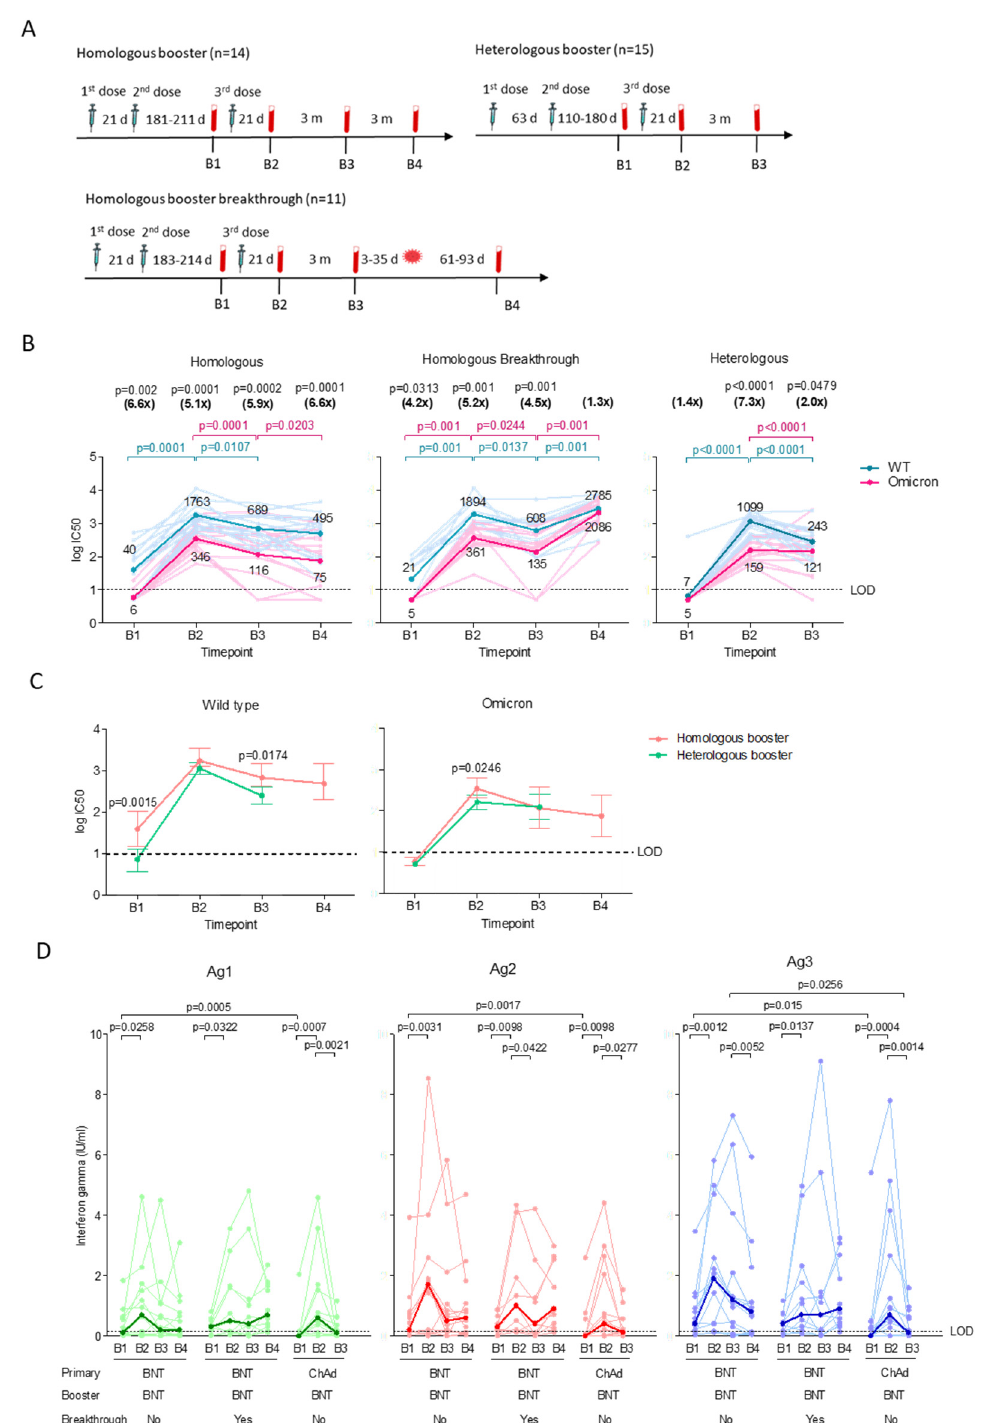
Figure 2. Neutralizing antibody and T cell responses of individuals who received a homologous (BNT-primed + BNT) ( n = 14) booster and those who subsequently experienced breakthrough infection ( n = 11), and heterologous (ChAd-primed + BNT) ( n = 15) booster. ( A ) Longitudinal study design. Blood samples were collected before booster (B1), and 21 days (B2), 3 months (B3), and 6 months (B4) after the booster. For homologous booster breakthrough group, B4 sample was col- lected at 61–93 days after breakthrough infection. ( B ) Neutralizing antibody titers (log IC 50 ) against